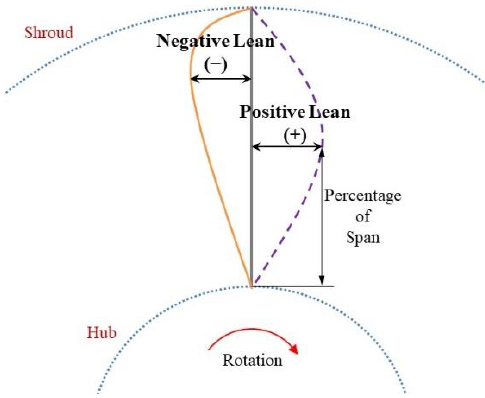
Figure 5. The definition of inducer blade